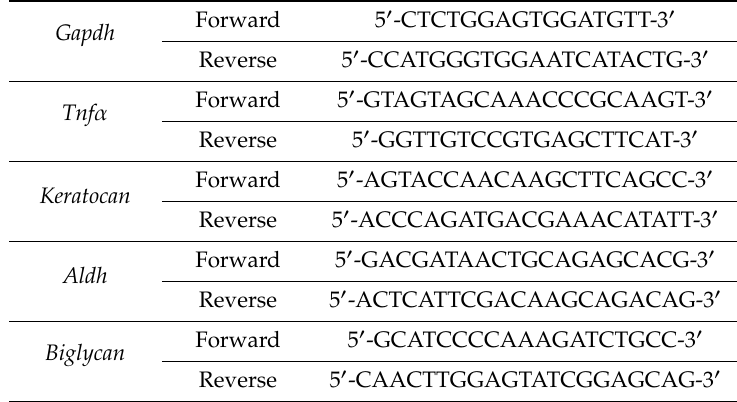
Table 1. Gene primers used to assess gene expression in TDPs treated corneas.